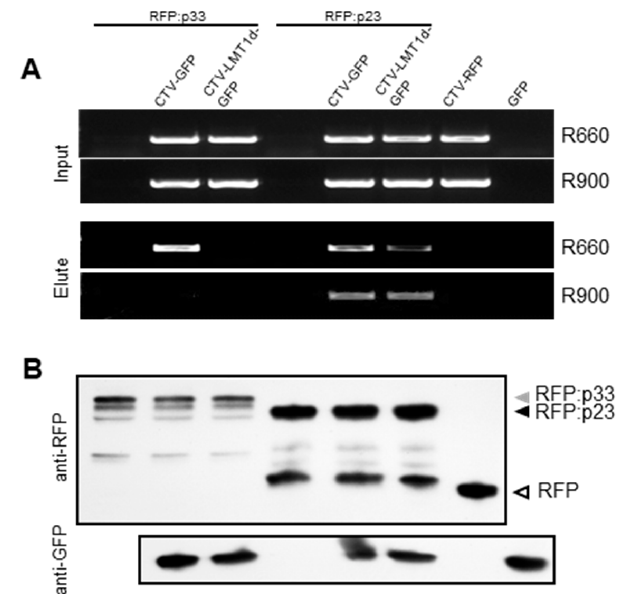
Figure 4. Comparison of the RNA binding properties of two CTV proteins—p33 and p23. The im- ages show RT-PCR products and proteins in the corresponding RIP assay analyzed by agarose gel electrophoresis ( A ) or by immunoblot assay ( B ), respectively. ( A ) Each panel shows RT-PCR products generated using the total RNA extracted from the Input and Elute steps of the RIP assay (top and bottom, respectively). Two sets of primers, which included reverse primers R660 and R900, were used to differentiate the shorter LMT1 RNA from the longer genomic RNA. CTV-RFP (CTV-WT expressing free RFP) and GFP were used as controls to rule out the RFP-Trap precipitation of CTV RNA in the presence of non-tagged CTV proteins and free RFP or GFP, respectively. ( B ) Immunoblot analysis of the total protein extracts used as “Input” with an anti-GFP antibody to detect expression of free GFP produced by the CTV variants or the GFP control and an anti-RFP antibody to detect RFP-tagged proteins and free RFP produced by CTV-RFP.